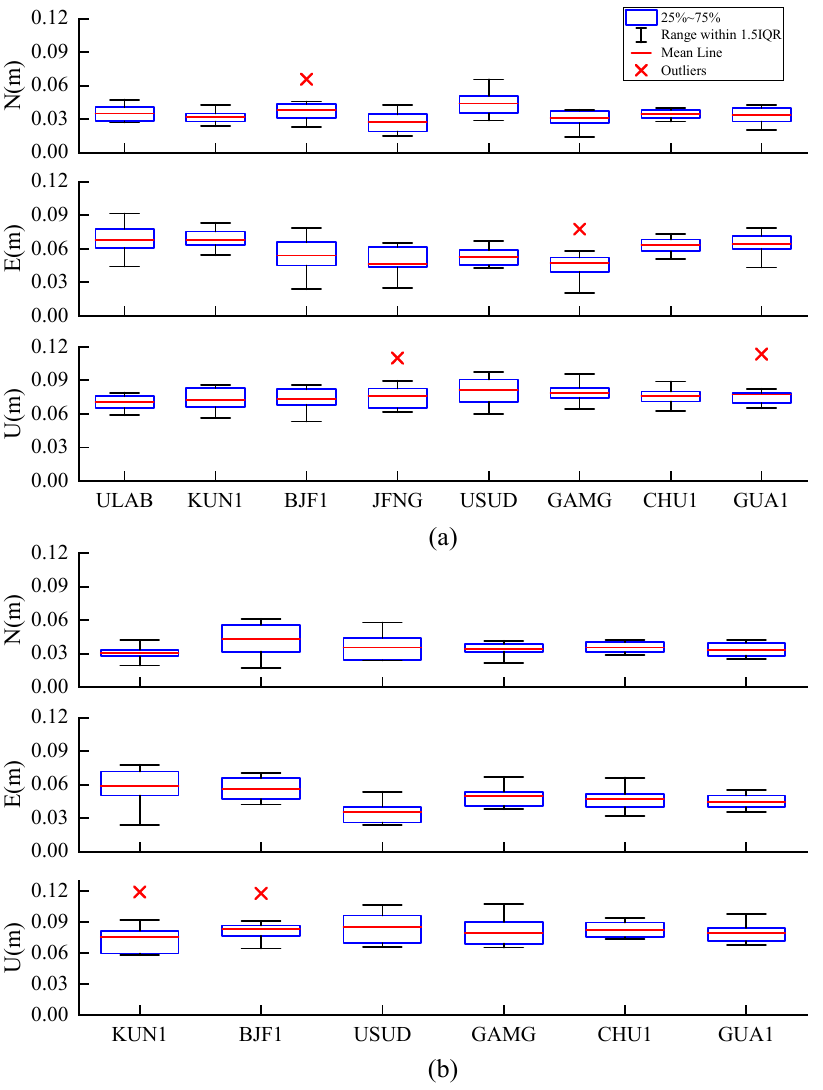
Figure 10. ( a ) PPP-B2b position error RMS values using BDS B1I/B3I + GPS in the simulated kinematic mode; ( b ) PPP-B2b position error RMS values using BDS B1C/B2a + GPS in the simulated kinematic mode. Table 8. Mean RMS values of PPP-B2b kinematic positioning at each station using B1I/B3I.